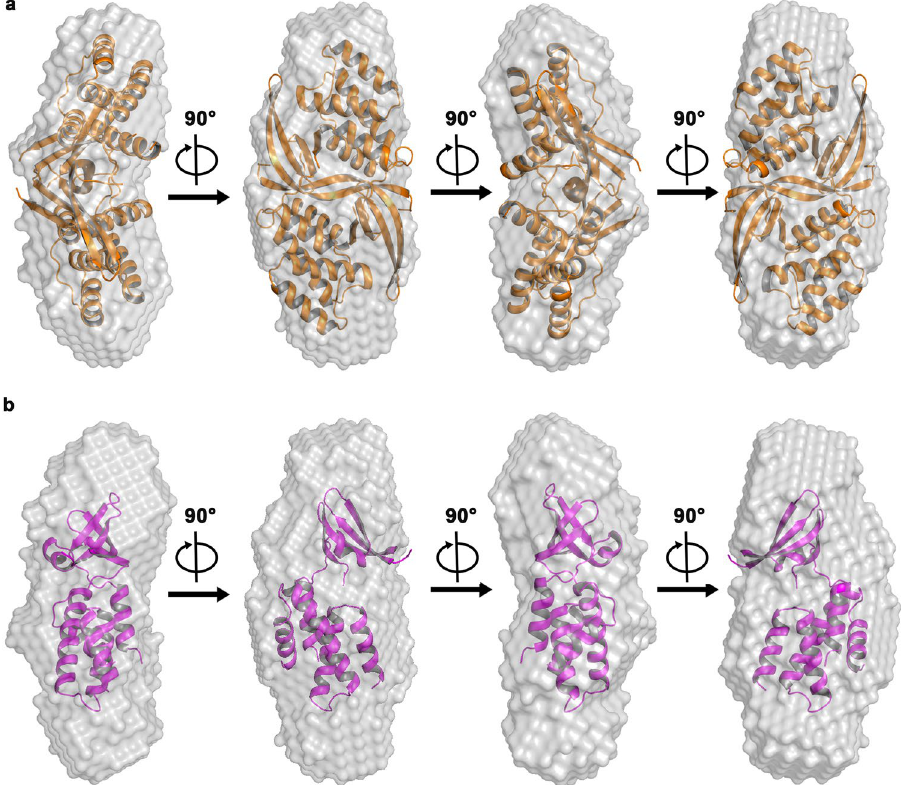
Figure 3. CarD exists as a homodimer in solution. SAXS-derived envelope of CarD was superposed using the available crystal structures of Mtb CarD using SUPCOMB. The crystal structure of the domain-swapped dimeric CarD fits well into the SAXS calculated envelope (NSD = 0.96, Fig. 3 a ) whereas the superposition of the monomeric CarD (NSD = 3.2, Fig. 3 b ) leaves multiple regions in the SAXS envelope unaccounted, suggesting a poor